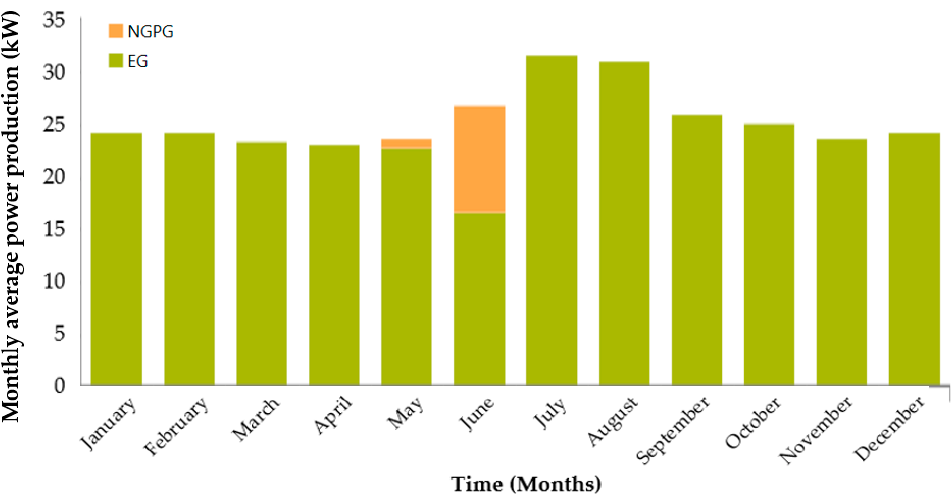
Figure 15. Share of power production in EG + NGPG + BES based power supply system configuration [Note: EG-Electric grid; NGPG-Natural gas power generator; BES-Battery energy storage].